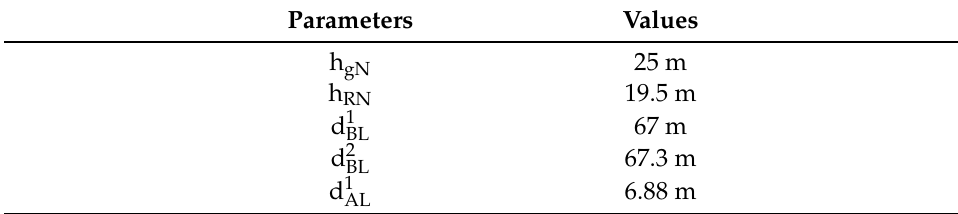
Table 3. Distance of the simulation